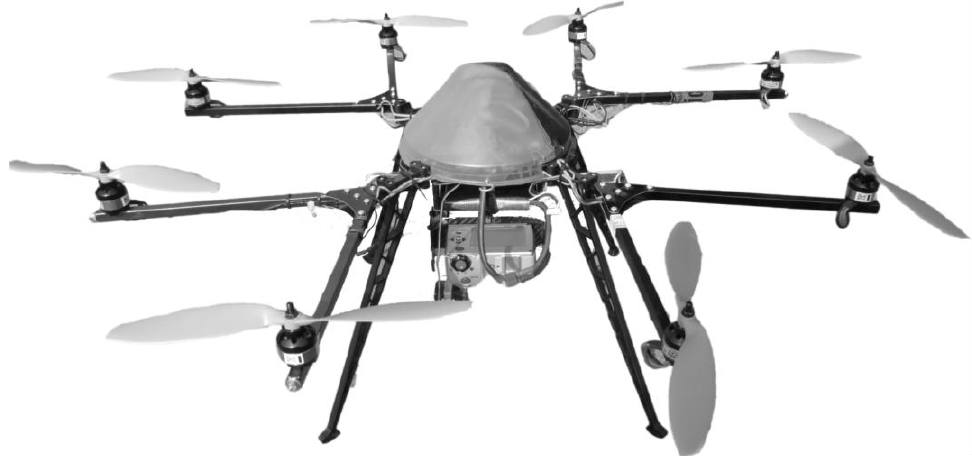
Figure 2. Mini-UAV MK-Okto by HiSystems GmbH (HiSystems GmbH, 2012) equipped with NEC F30 IS thermal imaging